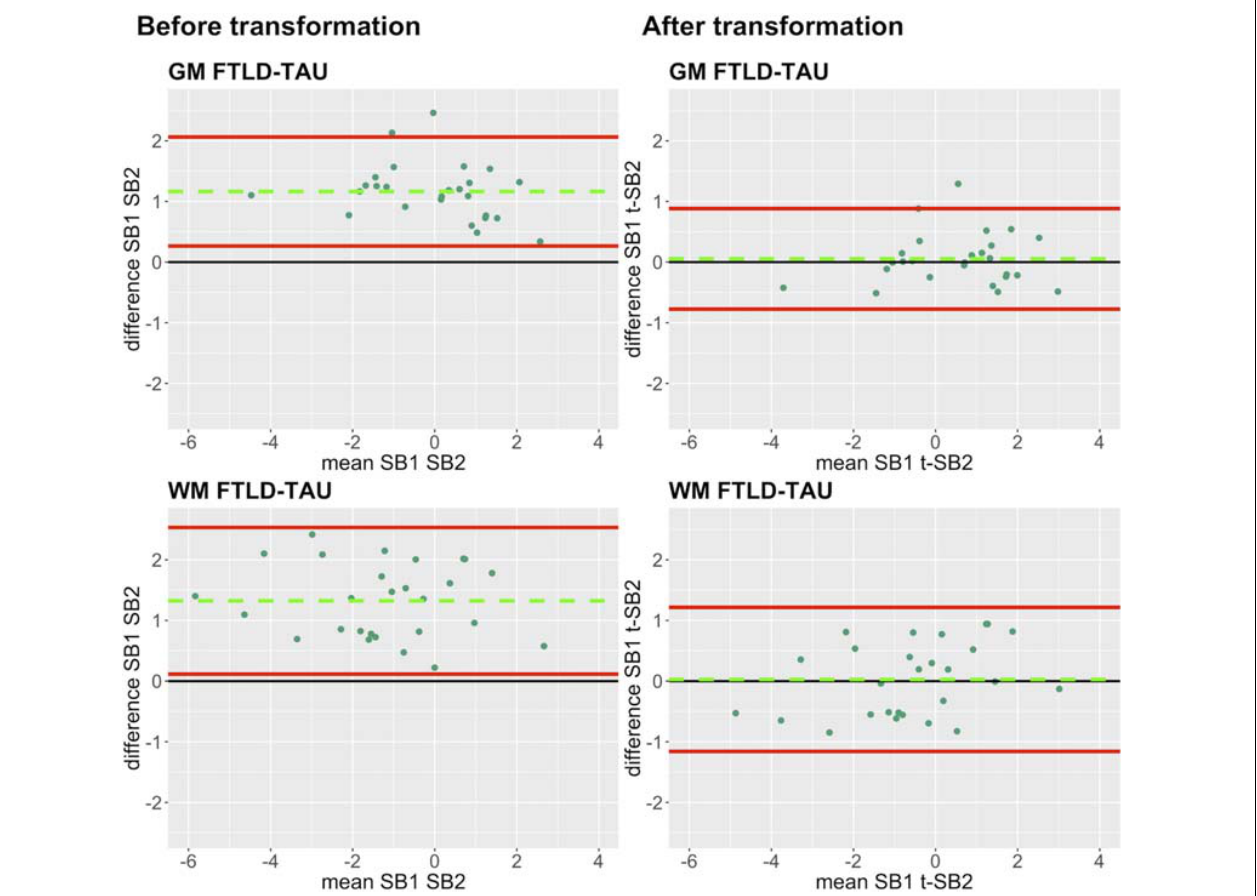
FIGURE 5 | Bland-Altman plots of test-retest agreement between duplicate measurements of pathology before vs. after transformation in FTLD-Tau. Plots portray test-retest agreement between duplicate measurements of digital pathology (i.e., ln %AO) in FTLD-Tau from SB1 and SB2 before and after transforming the data using our validated linear regression-based method. Here we illustrate the reduction in batch-related difference in digital measurements resulting from the application of our transformation method in a single train-test split in FTLD-Tau (Step 3). The green dashed line indicates the mean difference between SB1 and SB2 measurements, while the red solid lines mark the 95% limits of agreement between the two measurements. We find that mean difference between SB1 and SB2/t-SB2 is significantly different from zero before transformation ( p < 0.05, one-sample t -test), whereas it is not significantly different from zero after transformation ( p > 0.05) in both GM and WM. FTLD-Tau, frontotemporal lobar degeneration with inclusions of the tau protein; GM, gray matter; SB1, staining batch 1 (original); SB2, staining batch 2 (new); t-SB2, transformed staining batch 2 (new); WM, white